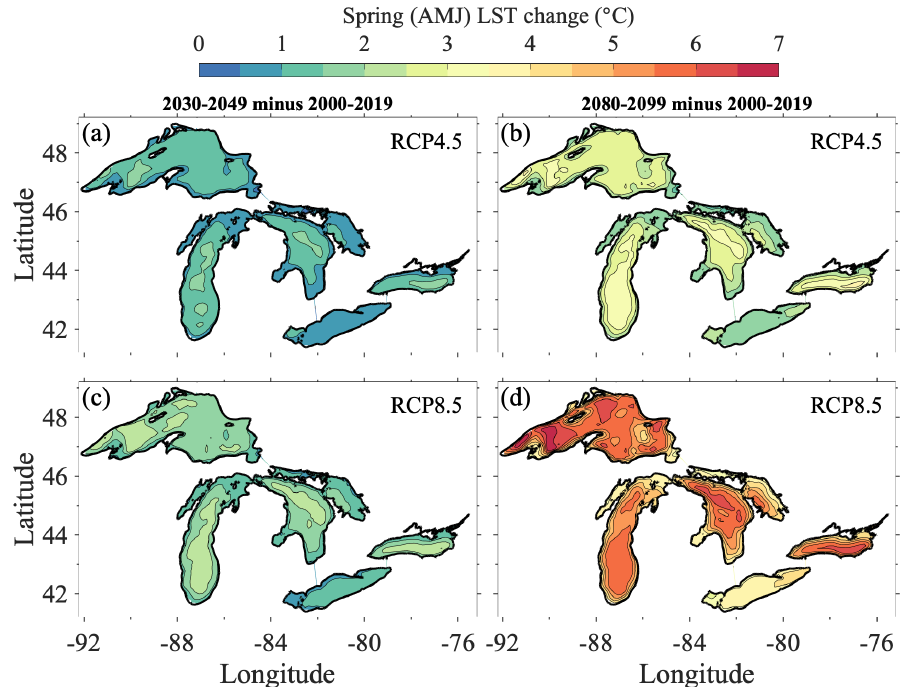
Figure 11. Projected changes in spring (AMJ) LSTs in the five Great Lakes in the mid-century (2030–2049) and late-century (2080–2099) for the RCP 4.5 (a, b) and RCP 8.5 (c, d) scenarios, relative to the present-day climate (2000–2019).